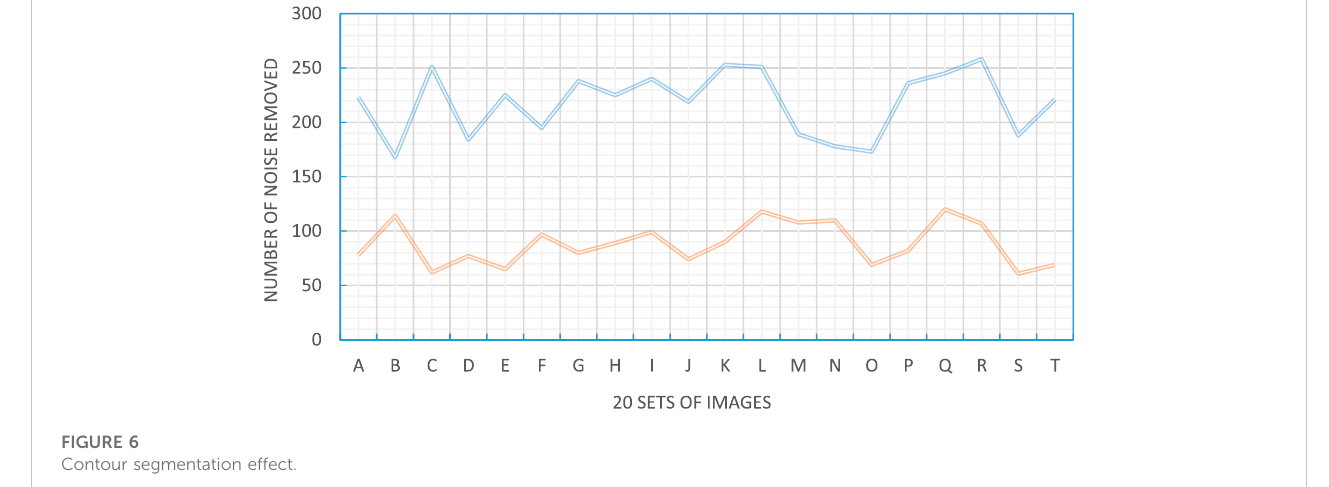
FIGURE 6 Contour segmentation effect.